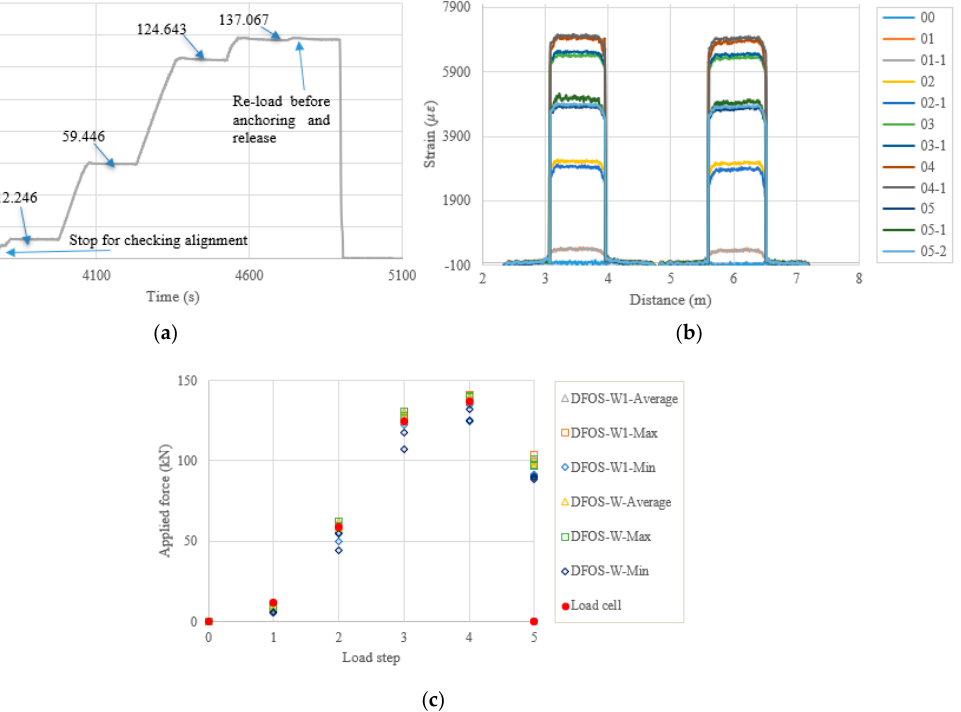
Figure 12. ( a ) Load cell readings for PC3-2; ( b ) strain distribution along the strand (W1 and W fibers) (In the legend, the first number represents the load step, and the second number represents measurement times at the load step); and ( c ) applied force changes at different load steps.